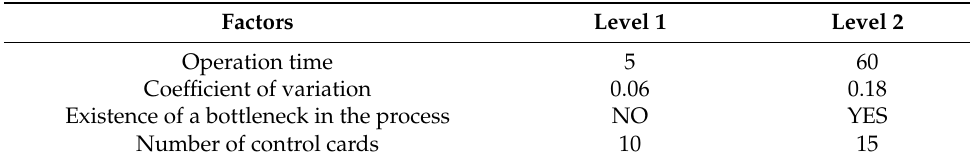
Table 2. Factor levels. Factors Level 1 Level 2 Operation time Existence of a bottleneck in the